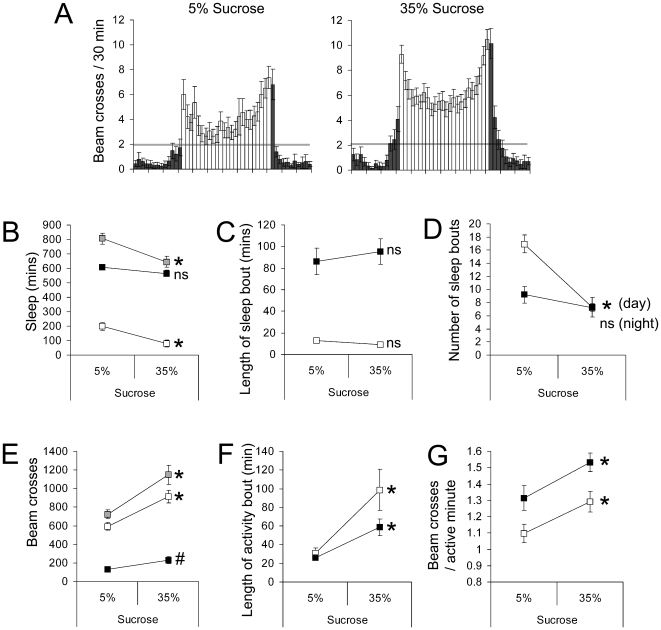
Effect of dietary sucrose on male Drosophila sleep-wake behaviour.Male w1118 flies were fed diets containing different sucrose concentrations and their sleep-wake behaviour monitored for three consecutive days. (A) Activity plots binned to every half-hour of the 24-hr cycle for flies fed the different diets; dark bars represent night and day activity, respectively. The grey bar denotes an average of 2 beam crosses per half hour and is presented to aid comparisons of the data. (B) Sleep (periods of 5 minutes without a fly crossing the beam) of flies on the two diets. (C) Length of sleep bouts. (D) The number of sleep bouts. (E) The amount of locomotor activity undertaken by flies on the different diets. (F) Average length of activity bouts. (G) Intensity of activity bouts. Grey boxes refer to 24 hr data, open boxes refer to the 12 hour light period and filled boxes relate to data collected during the 12-hour dark period. *P<0.01; #P<0.05; n = 32 flies for each diet and is representative of four independent trials.